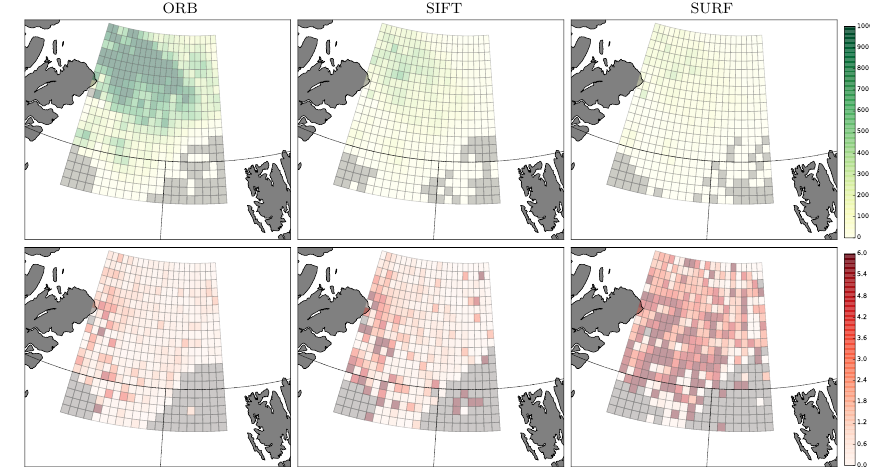
Figure 9. Sea ice drift derived from 43 Sentinel-1 image pairs (Fig. 8) using both HH and HV channel and ORB (first column, 177513 vec- tors), SIFT (second column, 43260 vectors) and SURF (third column, 25113 vectors) algorithm. The panels show the sum of the number of vectors per grid cell N (green, first row) and mean root mean square distance D in km (red, second row).